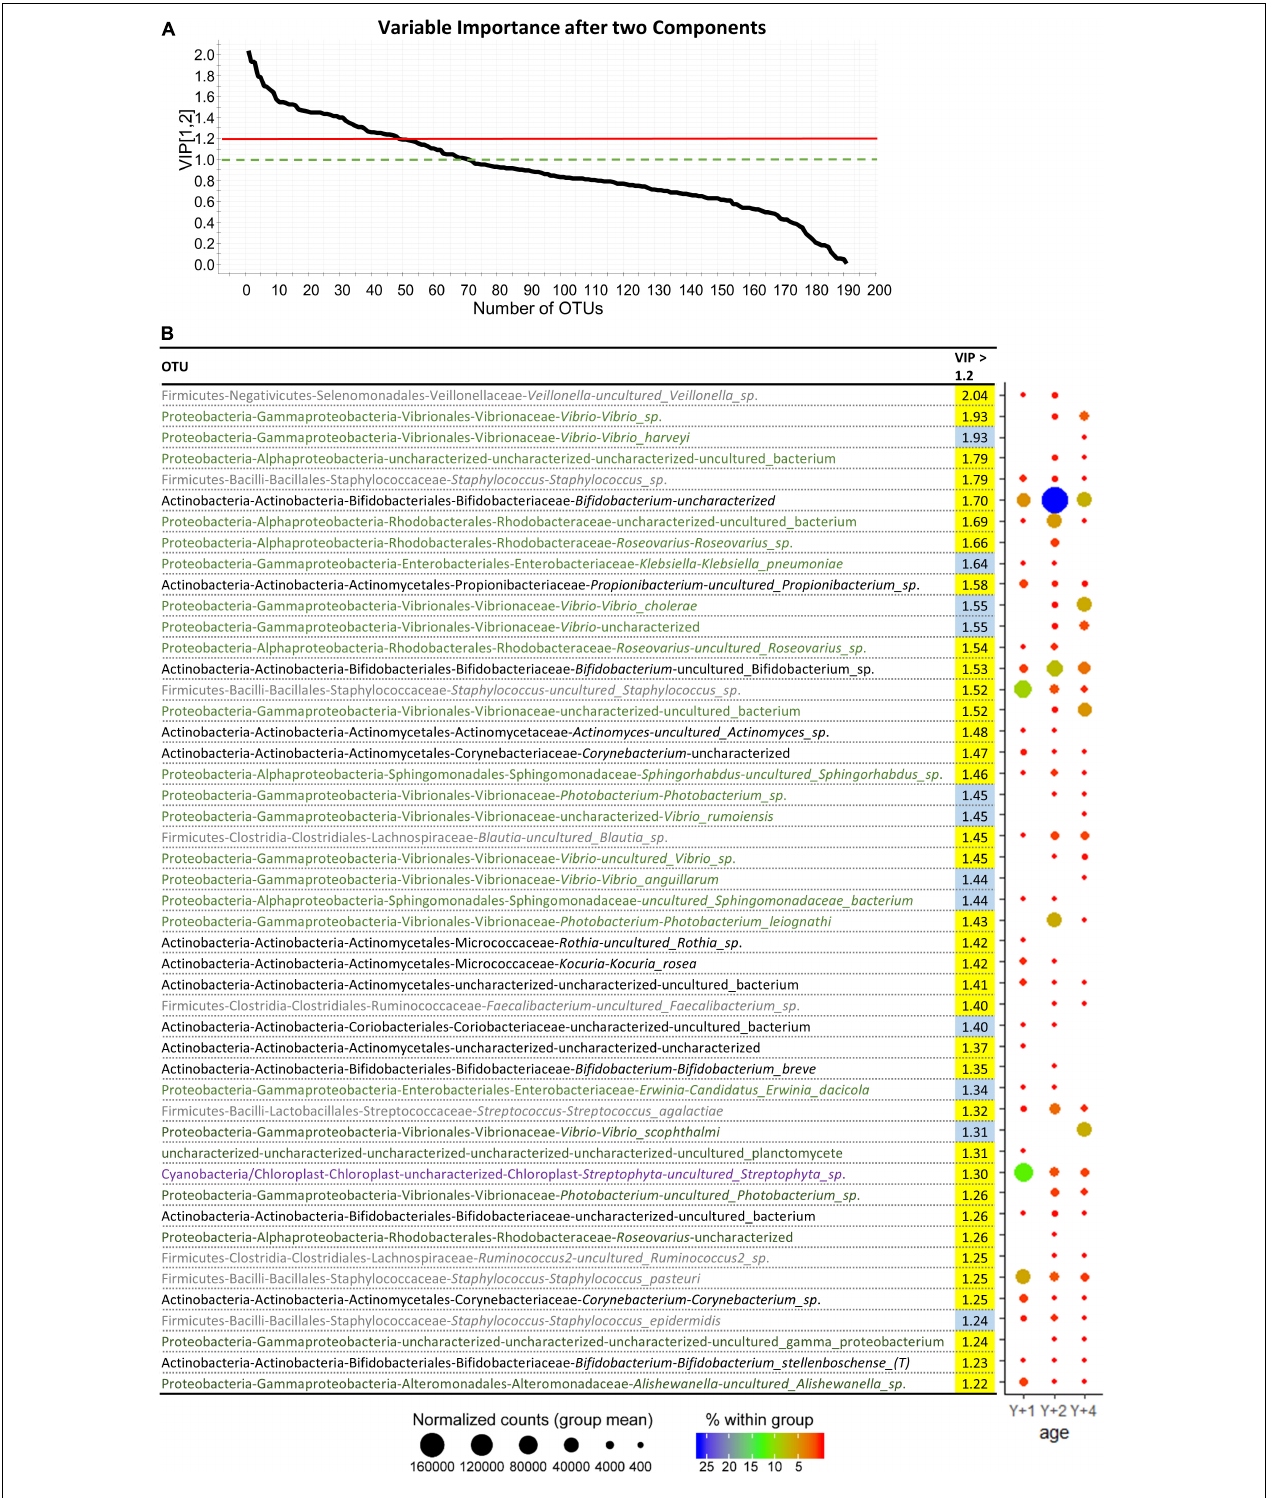
FIGURE 5 | (A) Graphical representation of the variable importance (VIP) scores after component 2. (B) Dotplot map of OTUs with variable importance in projection (VIP) > 1.2 after two components. VIP values in yellow represent the ones with importance in component 1, whereas the ones in blue appear after component 2. The size of the dots represents the normalized counts in each group. The color scale represents the abundance, in percentage, of each genus within each group. Y + 1, Y + 2, and Y + 4 correspond to 1, 2- and 4-year-old gilthead sea bream, respectively.